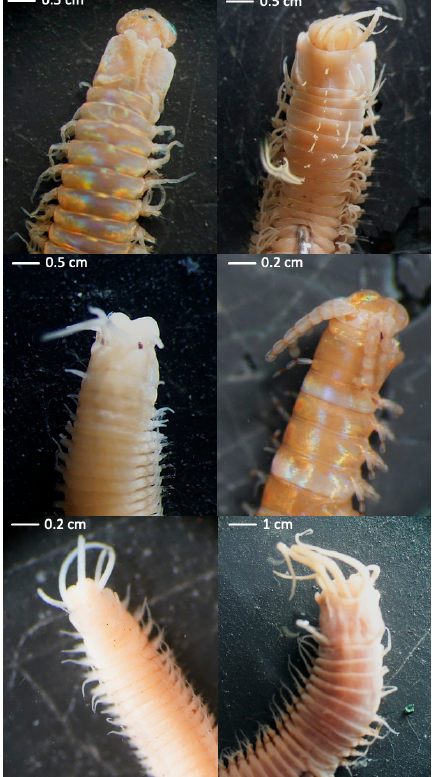
Figure 2. Anterior end in dorsal view of the species of the genus Eunice sensu lato found in the mesophotic bioconstructions investigated in the Southeastern Italian coast: upper line E. dubitata (left), E. floridana (right); middle line E. schizobranchia (left), E. torquata (right); bottom line E. pennata (left) E. norvegica (right).